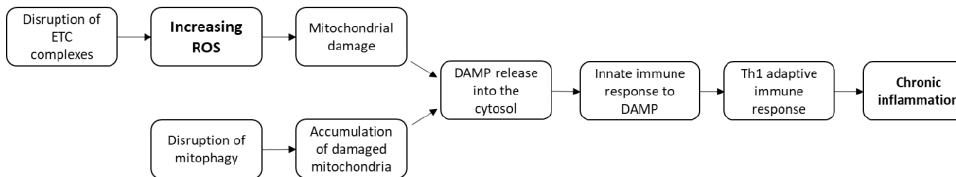
Figure 2. Models of CD pathogenesis with inflammation induction by DAMP.